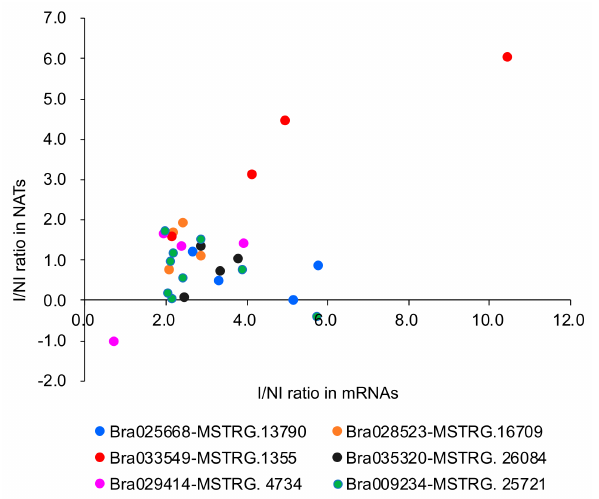
Figure 6. Scatter plot representing the ratio of the expression levels of mRNAs and their paired NATs following F. oxysporum f. sp. conglutinans ( Foc ) inoculation (I) compared with non-inoculated (NI).